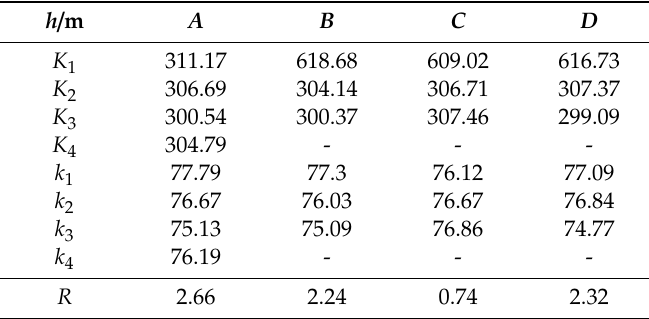
Table 15. 1.4 Q e ffi ciency